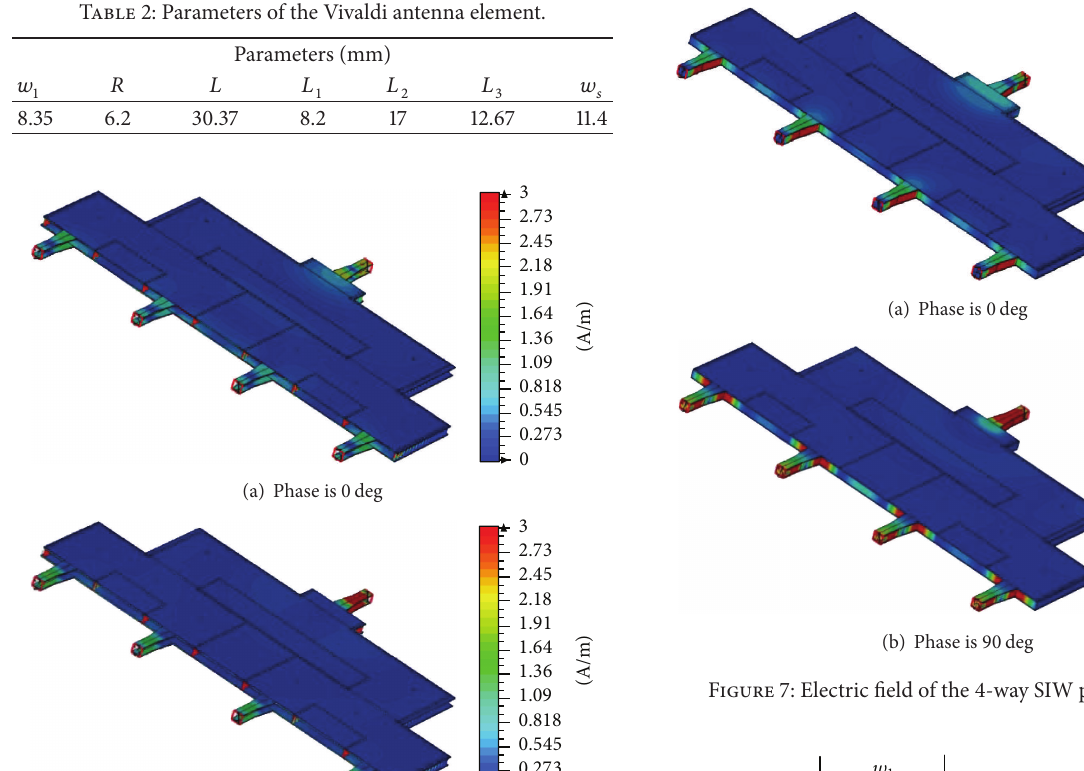
structure is designed for measurement and connection. The transition section is a tapered microstrip line.